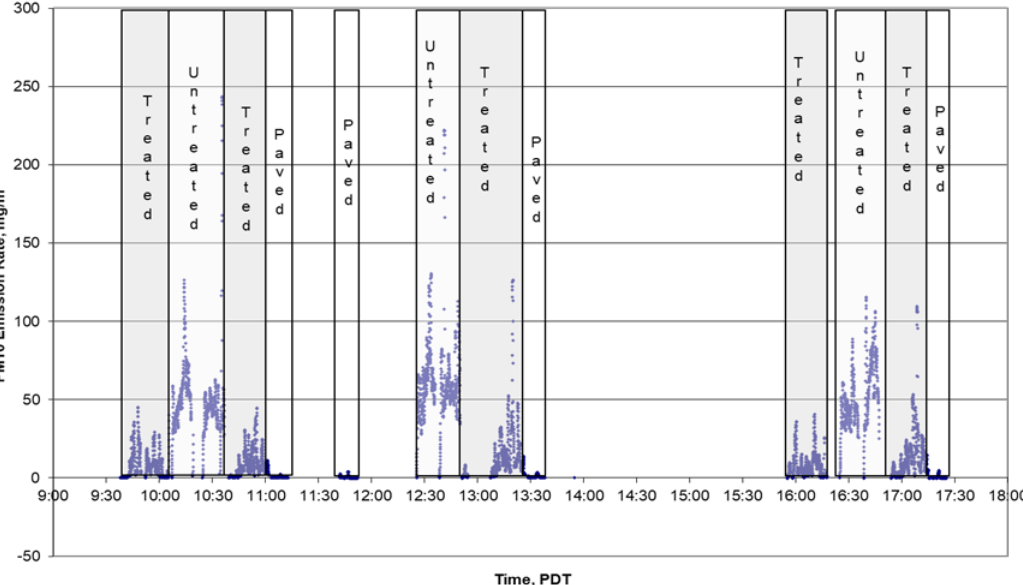
Figure 3. Time series plot of PM 10 emission rates during the test conducted on SR88. Table 1. Summary of mean PM 10 emission rates (ER) for the test route on SR88. Segment,